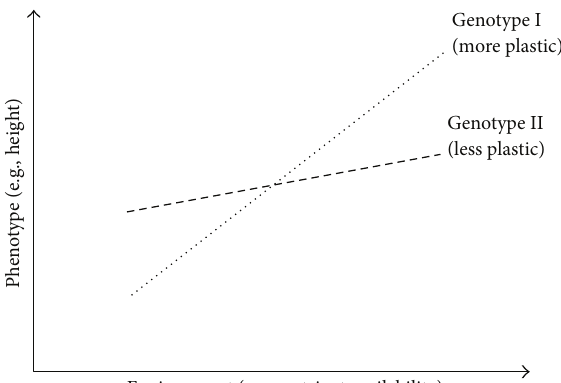
Figure 3: The lines represent the reaction norms (i.e. the genotype- specific environment-phenotype functions) of each genotype. Both lines have a slope in the environment-phenotype space, which means that both genotypes are plastic. The population shows GxE in the sense that there is genetic variation for the slope of the reaction norm, which would be detected by a standard analysis of variance from